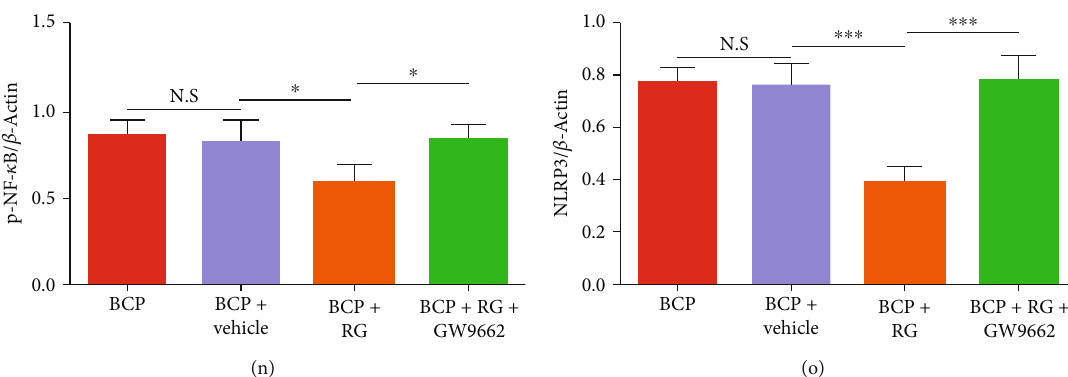
Figure 5: Rosiglitazone attenuates bone cancer pain (BCP) through the activation of proliferator-activated receptor- γ (PPAR- γ ) to inhibit the nuclear factor-kappa B (NF- κ B)/nod-like receptor protein 3 (NLRP3) in fl ammatory axis in spinal cord neurons. (a – c) Tumor cell inoculation signi fi cantly induced the activation of NF- κ B and NLRP3 in the spinal cord of BCP rats ( ∗∗∗ p < 0 : 001 vs. the sham group; n = 4 , one-way ANOVA (a – c)). (d, e) Immuno fl uorescence results showed that in the dorsal horn of the spinal cord of BCP rats, p-NF- κ B (red) and NLRP3 (red) were primarily expressed in neurons (green) rather than astrocytes (green) or microglia (green). Lumbar enlargements were collected on day 18 after the operation or cancer cell inoculation. Sections were counterstained with DAPI (blue) to label cell nuclei. The white arrows indicate colocalization of p-NF- κ B and NLRP3 with NeuN (neuronal nuclei, neuronal-speci fi c marker), GFAP (glial fi brillary acidic protein, astrocyte speci fi c marker), and IBA-1- (ionized calcium binding adapter molecule 1, microglial speci fi c marker) immunoreactive cells in the spinal dorsal horn, respectively; n = 4 . Scale bar = 50 μ m. n represents the number of experimental animals in each group. (f – i) Repeated intrathecal injection with PDTC, an NF- κ B inhibitor, signi fi cantly inhibited the established BCP ( ∗∗ p < 0 : 01 and ∗∗∗ p < 0 : 001 vs. the vehicle control group; n = 6 , two-way repeated measures ANOVA (i)) and BCP-induced NF- κ B/NLRP3 activation ( ∗∗∗ p < 0 : 001 vs. the vehicle control group; n = 4 , one-way ANOVA (f – h)). (j – l) Repeated intrathecal injection with MCC950, an NLRP3 inhibitor, signi fi cantly inhibited the established BCP ( ∗∗ p < 0 : 01 and ∗∗∗ p < 0 : 001 vs. the vehicle control group; n = 6 , two-way repeated measures ANOVA (l)) and BCP-induced NLRP3 activation ( ∗∗∗ p < 0 : 001 vs. the vehicle control group; n = 4 , one-way ANOVA (j, k)). (m – o) Rosiglitazone inhibits the BCP-induced activation of the NF- κ B/NLRP3 in fl ammatory axis, whereas GW9662 reversed this e ff ect ( ∗ p < 0 : 05 and ∗∗∗ p < 0 : 001 vs. the vehicle control group; ∗ p < 0 : 05 and ∗∗∗ p < 0 : 001 vs. the BCP+RG group; n = 4 , one-way ANOVA (m – o)). N.S: not statistically signi fi